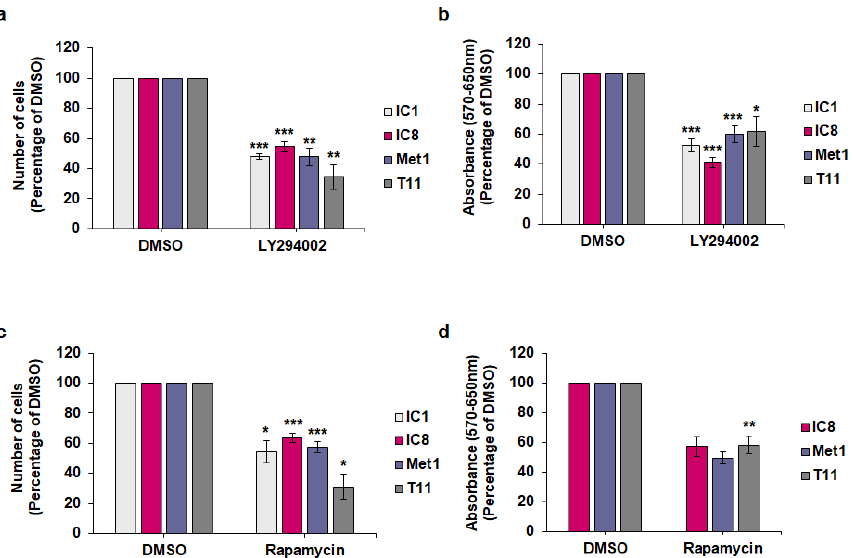
Figure 3. The PI3K/Akt/mTOR pathway regulates growth and viability of cSCC cell lines. The indicated cSCC cell lines were treated with 10 µM LY294002 ( a , b ) or 10 nM rapamycin ( c , d ) in complete medium supplemented with 10% FBS. Control cells were treated with vehicle alone (DMSO). After 72 h, number of cells was assessed by cell counting ( a , c ) and cell viability was assessed by MTT assays ( b , d ). Data are expressed as percentage of results from control cells and are means ± SEM from n = 4 (( a ), IC1, IC8, Met1), n = 7 (( a ), IC1); n = 5 (( b ), IC8), n = 7 (( b ), Met1), n = 4 (( b ), T11), n = 10 (( b ), IC1); n = 3 (( c ), IC1,T11), n = 6 (( c ), Met1), n = 9 (( c ), IC8); n = 2 (( d ), IC8, Met1) and n = 3 (( d ), T11) independent experiments performed in duplicate ( a , c ) or triplicate ( b , d ). * p < 0.05, ** p < 0.01, *** p < 0.001 vs.